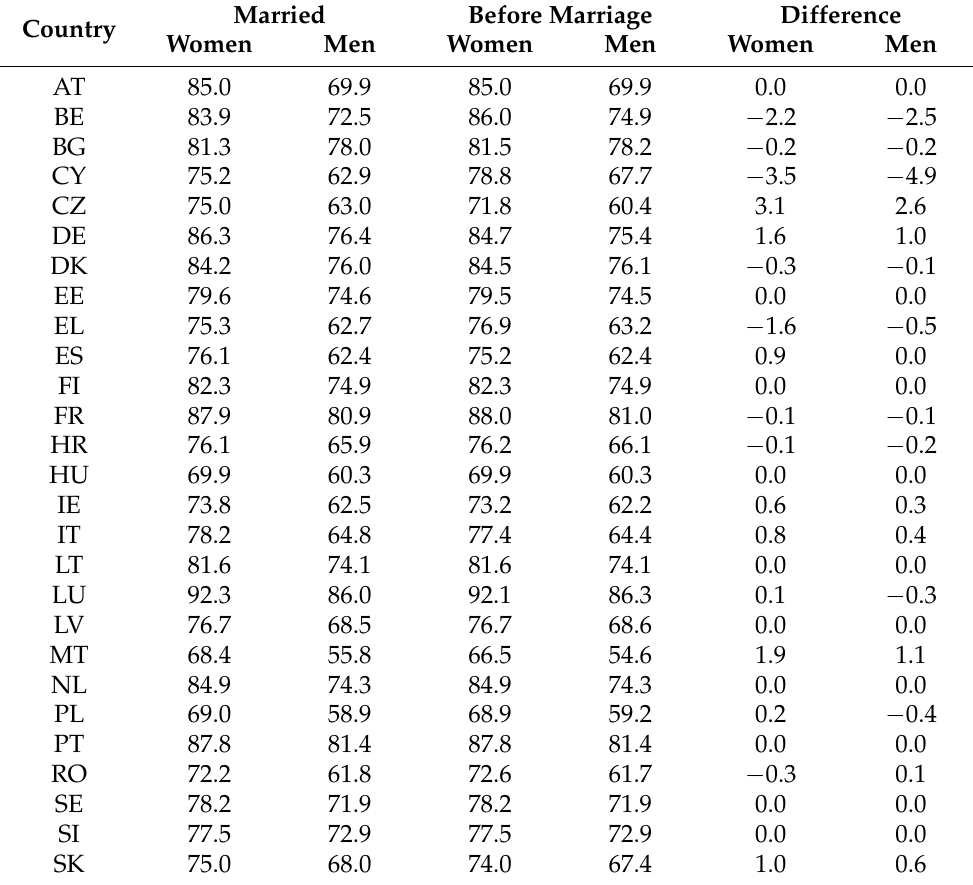
Table A4. The average NRR before and after marriage for all EU countries. Married Country